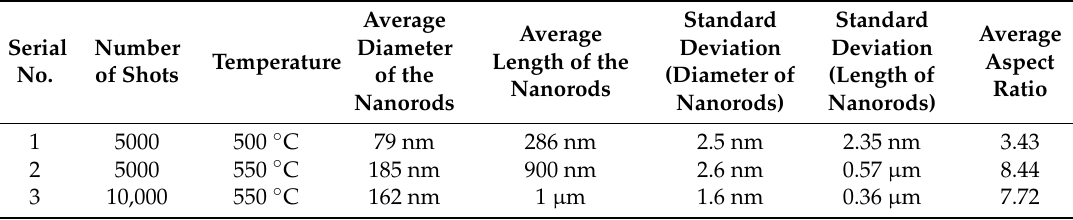
Table 1. Average diameter and lengths of VAZO nanorods grown by PLD